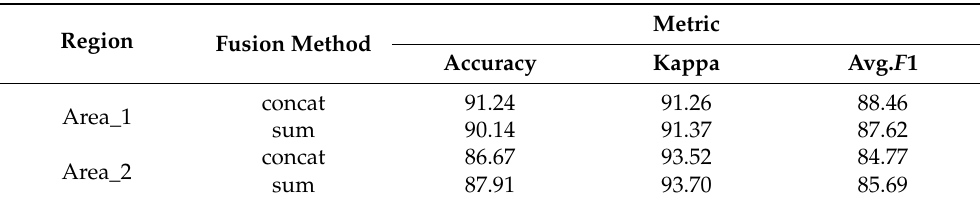
Table 9. Comparison of testing results with different fusion methods. The best results are highlighted in